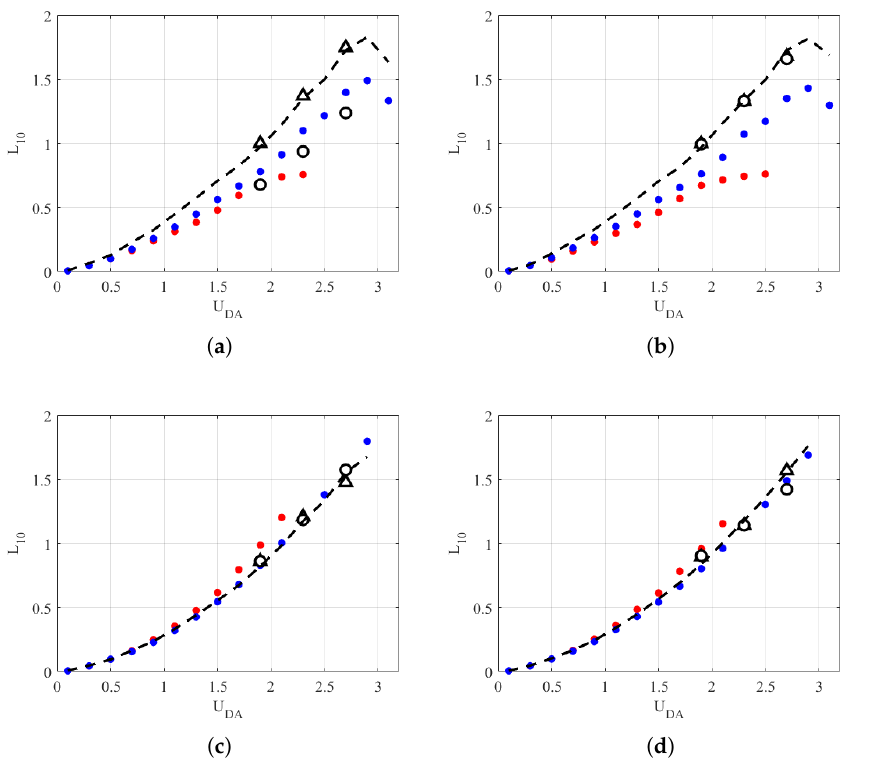
Figure 10. Normalised DEL for the range of flow speeds for each turbine position and tide. Predicted mean profiles and constant turbulence for location A (blue dot), predicted mean profiles and constant turbulence for location B (red dot), measured varying profiles and turbulence (black triangle), measured varying profiles with wave cases removed (black circle) and estimated loads from measured varying profiles (black dash). ( a ) Near Surface, Flood. ( b ) Near Surface, Ebb. ( c ) Near Bed, Flood. ( d ) Near Bed, Ebb.